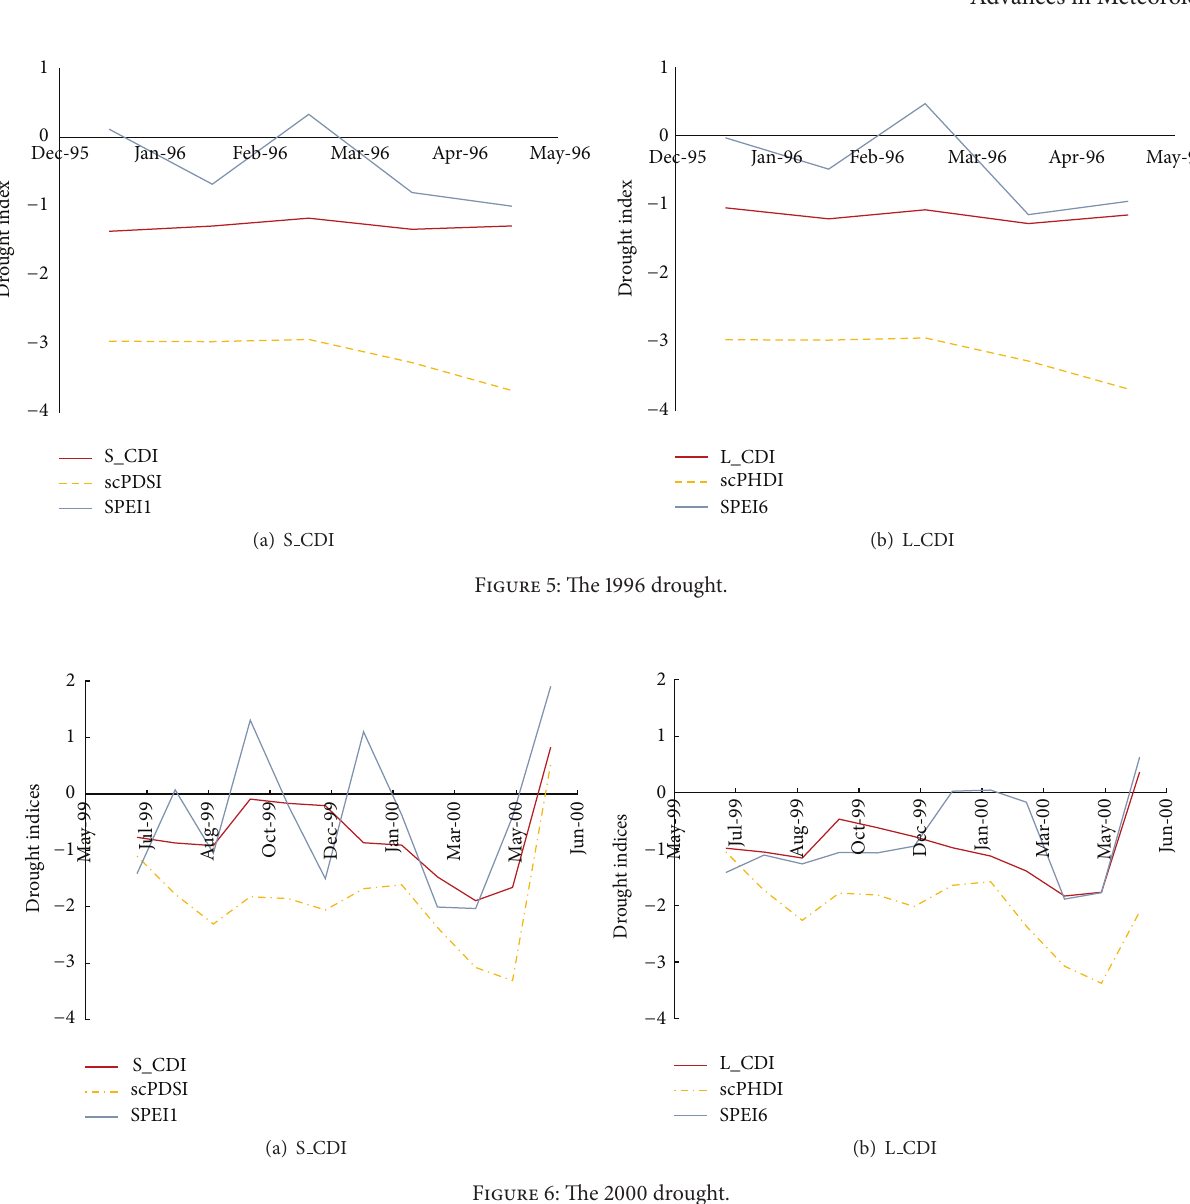
Figure 6: The 2000